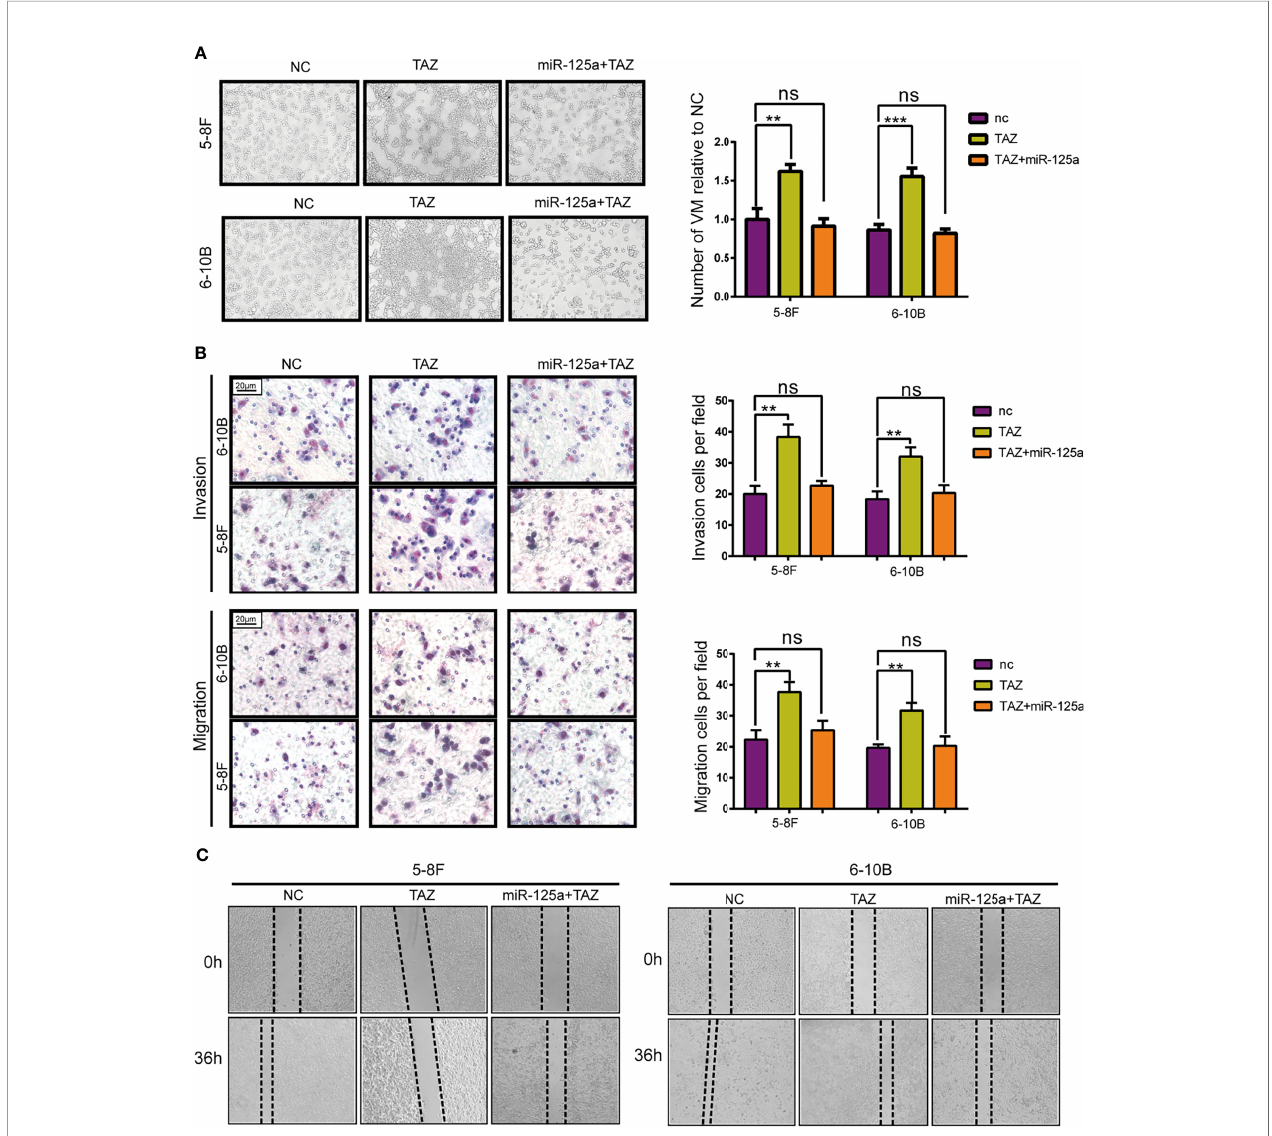
FIGURE 4 | TAZ mediates the tumor suppressing function of miR-125a. (A) VM formation assay (left panel) and bar graph showing relative number of VM (right panel). (B) Invasion and migration transwell assay and histogram showing cell counting per fi eld. (C) Wound healing assay. (ns, not signi fi cant; **P < 0.01; ***P <